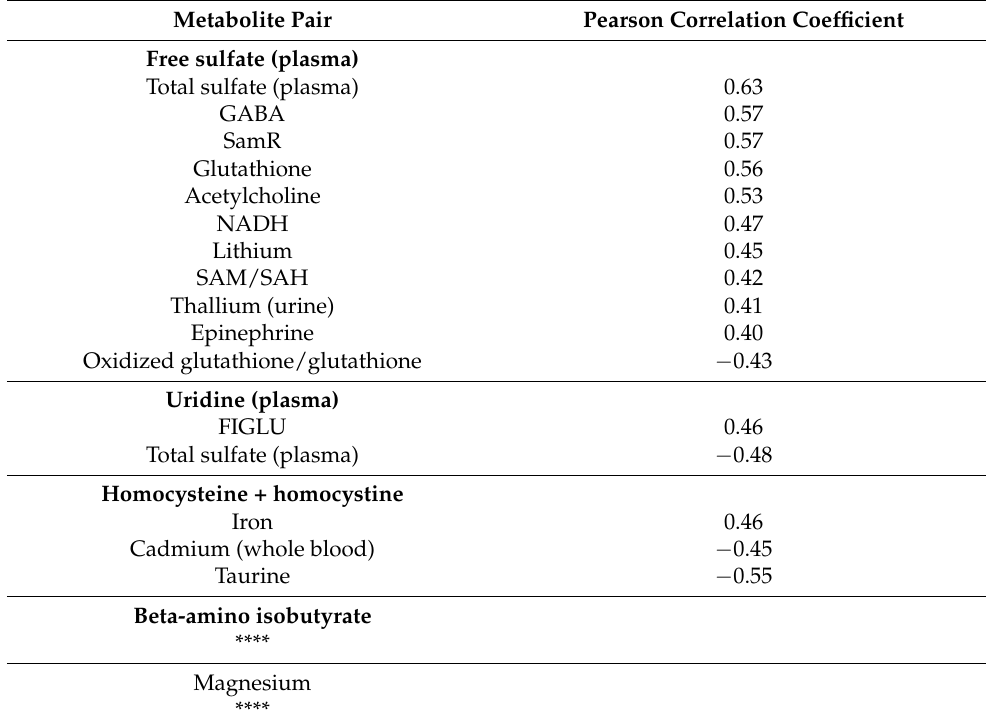
Table 3. Correlations of top-5 FDA optimized variables (bold) with other measurements, for the ASD group. For all relationships that met the inclusion criteria below see Table